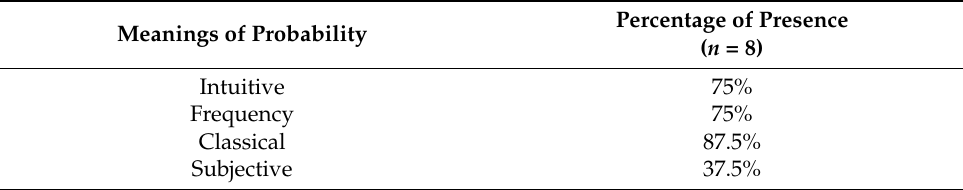
Table 7. Probability meanings present in the class sessions.